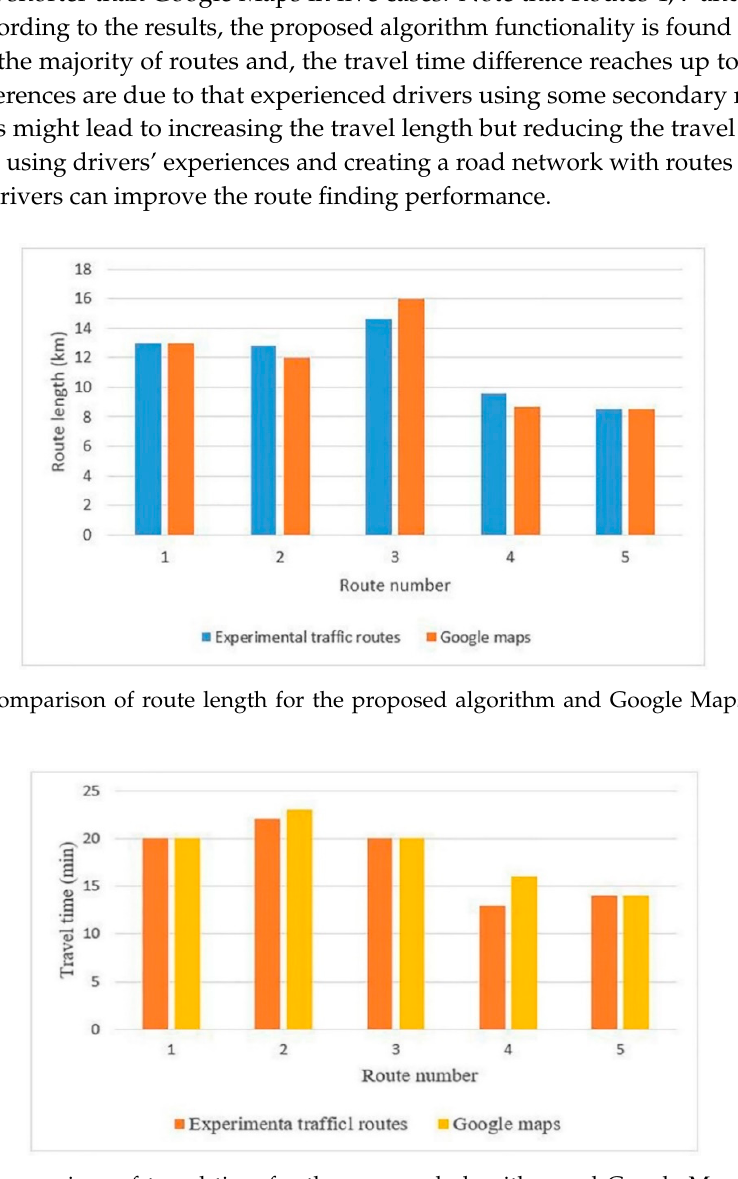
Figure 13. Comparison of travel time for the proposed algorithm and Google Maps at off-peak traffic times.